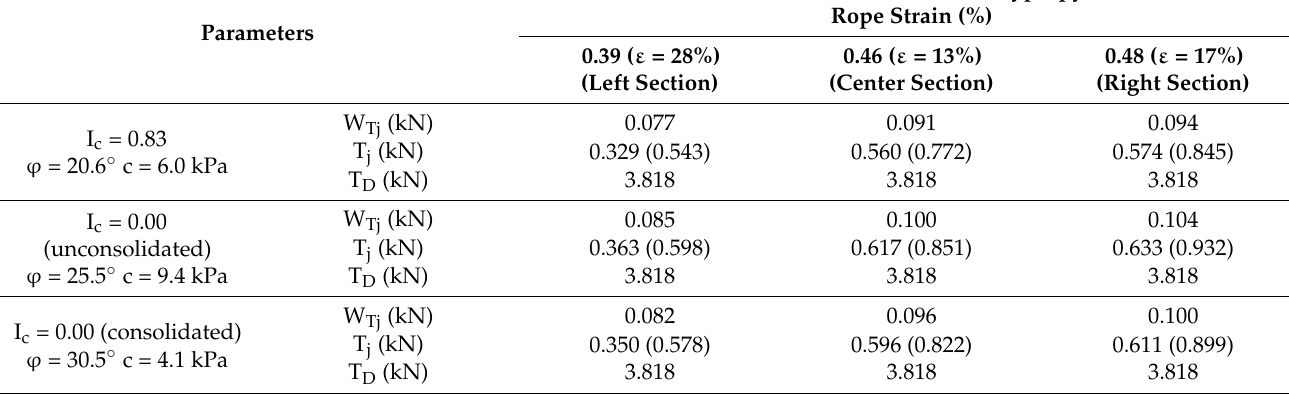
Table 6. Design tension force in the ropes placed on the slope part with an inclination of 1:1 in comparison to the rope design. tension strength (location 4).